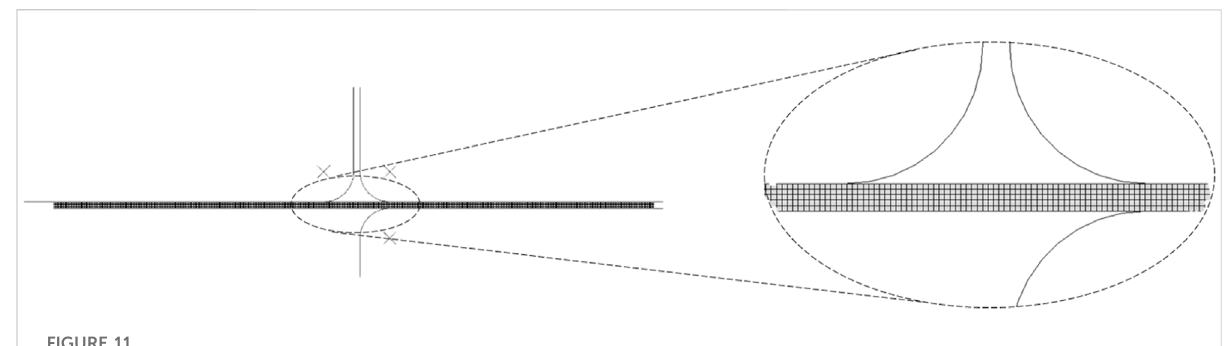
Close-up view of the developed FE mesh for the